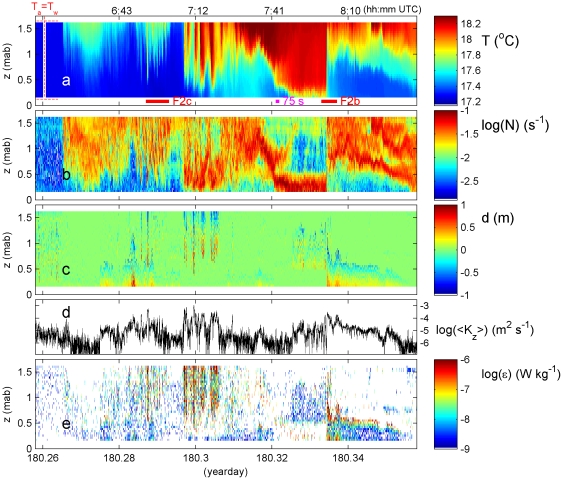
Depth-time series of T and computed turbulence parameters during 2.4 hours around high-water.a. Observed T-data. b. Stable stratification after reordering a. to stable profiles every time step and using δρ = −0.23δT kg m−3 °C−1 (see text). c. Overturning displacements following comparison of a. with its reordered data. d. Time series of vertically averaged eddy diffusivity using (2). e. Turbulence dissipation rate, estimated using (1). White also indicates values below threshold.